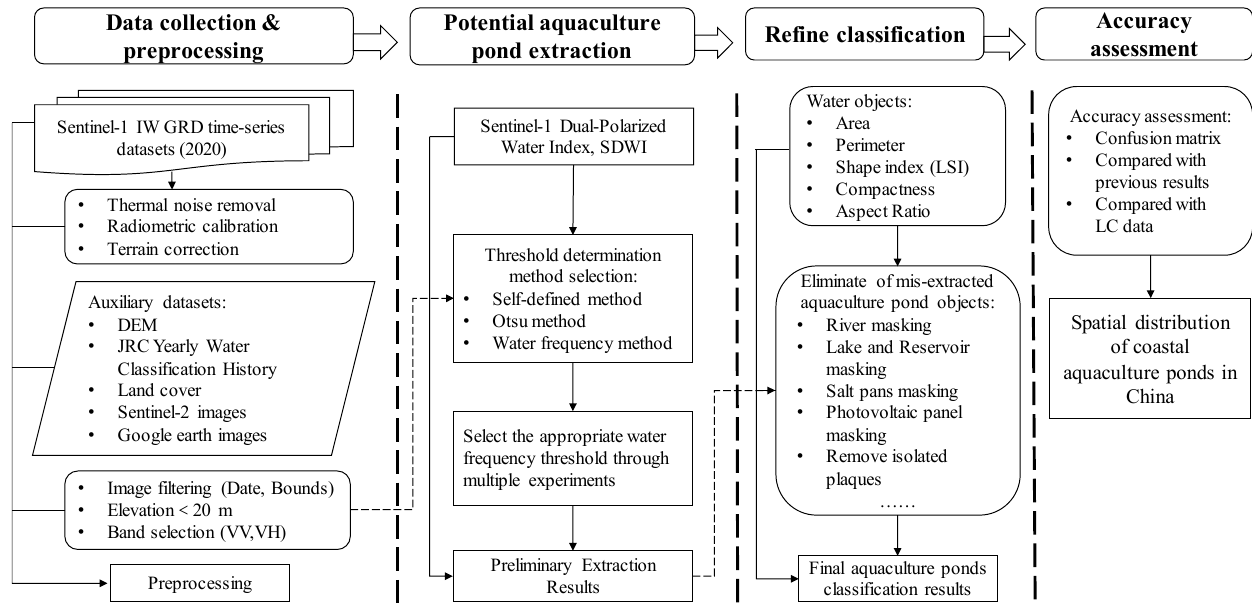
Figure 3. Extraction process from aquaculture ponds